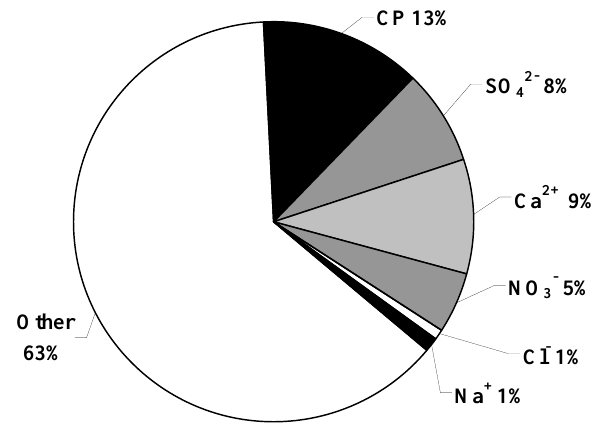
Fig. 13. Average chemical composition (mass percentage) of the deposited particles on the glass